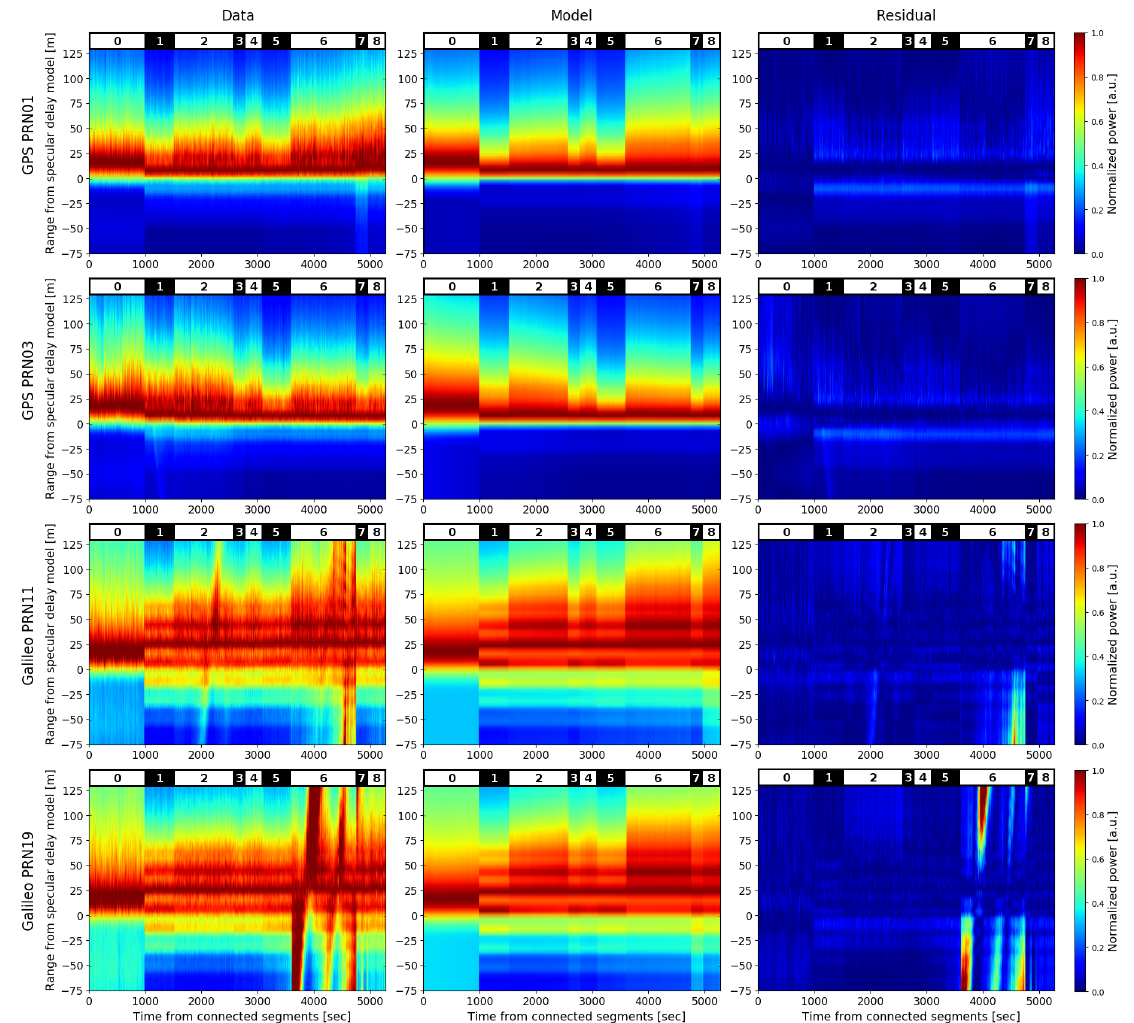
Figure 5. Left - to right -side: normalized power waveforms time-series from data, model and their difference (in absolute value). Up to bottom : GPS PRN01, GPS PRN03, Galileo PRN11 and Galileo PRN19. The markers on top of each panel indicate the intervals of the different tracks with their corresponding flight segment